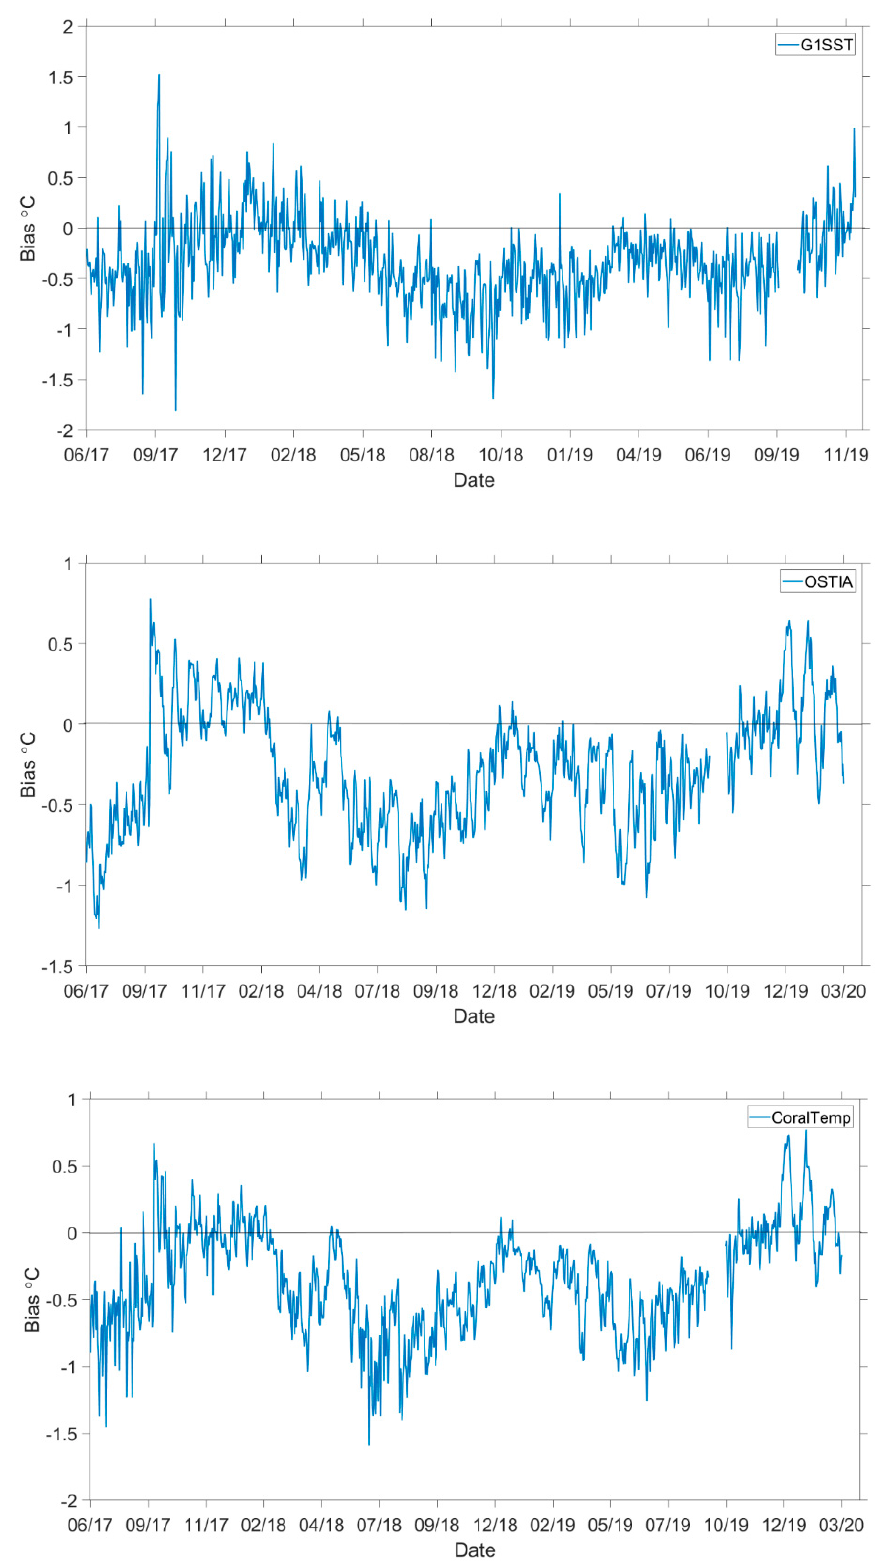
Figure 5. Time series of the bias (satellite—in situ) temperatures from 30 June 2017–1 March 2020 for Cayo Enrique and Cayo Mario.